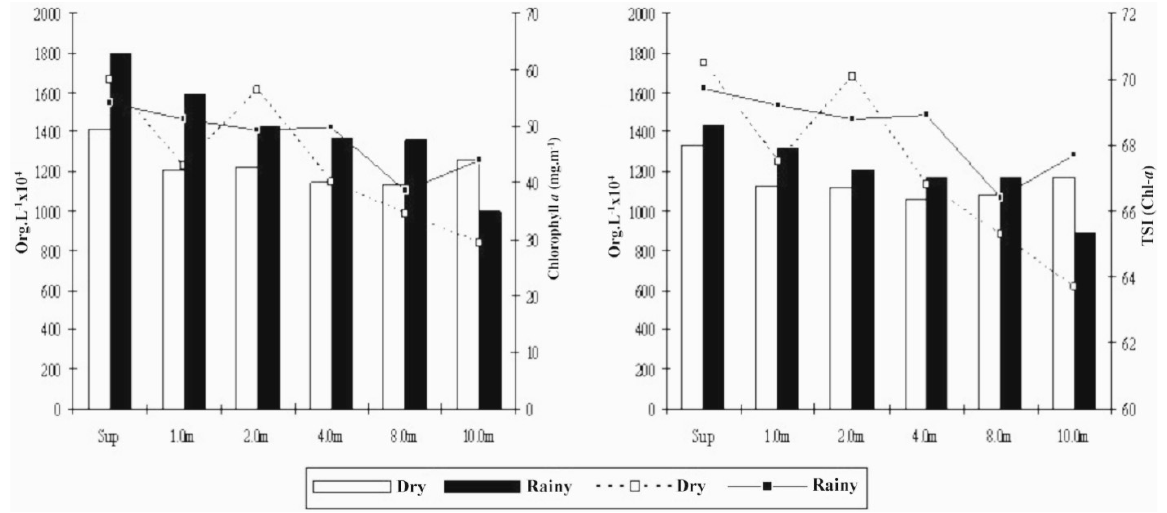
Fig. 2–A)Variationintotalphytoplanktondensity(columns)andChlorophylla(lines)betweentheanalyzeddepths.